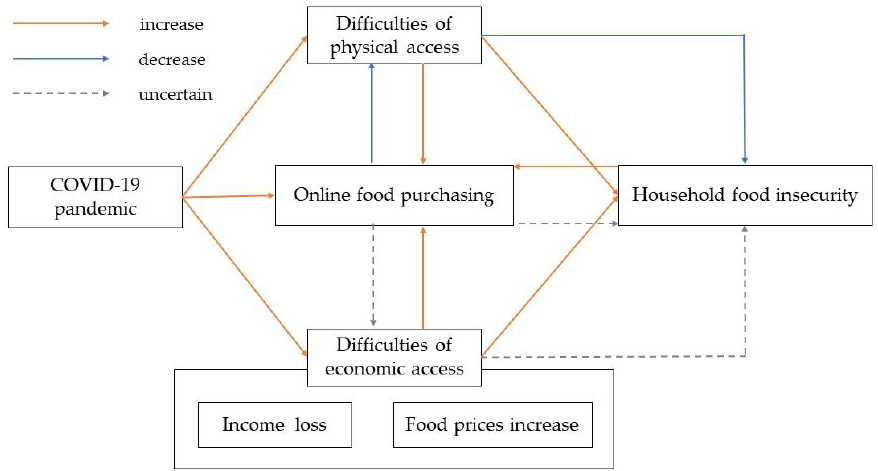
Figure 1. Relationship between COVID-19, household food insecurity, and online food purchasing. Source: Authors’ own compilation.